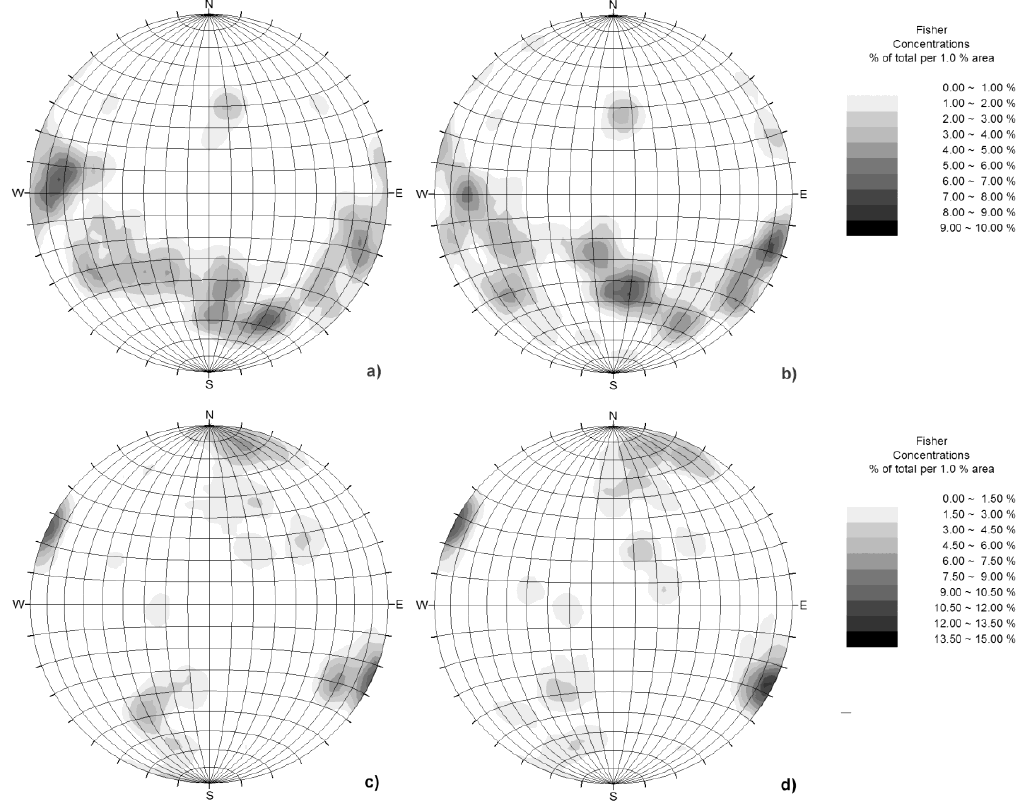
Fig. 4a-d Fig. 4. Density plots of poles for direct measurements ( a and c ) and non-contact estimations ( b and d ) of two test areas with respectively 89 and 102 geostructural data. Test areas are shown in Fig.